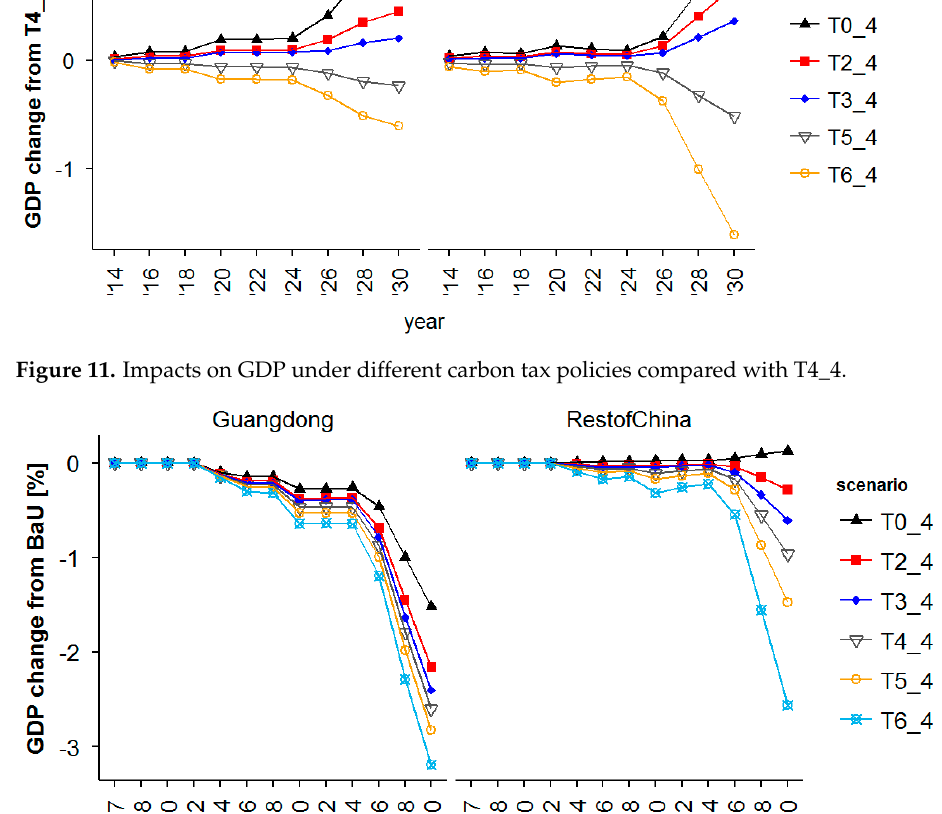
Figure 11. Impacts on GDP under di ff erent carbon tax policies compared with T4_4.